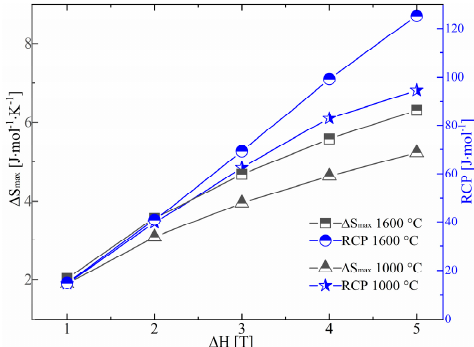
Figure 7. The Δ S max and relative cooling power of EuS compacts sintered at 1000 °C and 1600 °C. Figure 7. The ∆ S max and relative cooling power of EuS compacts sintered at 1000 ◦ C and 1600 ◦